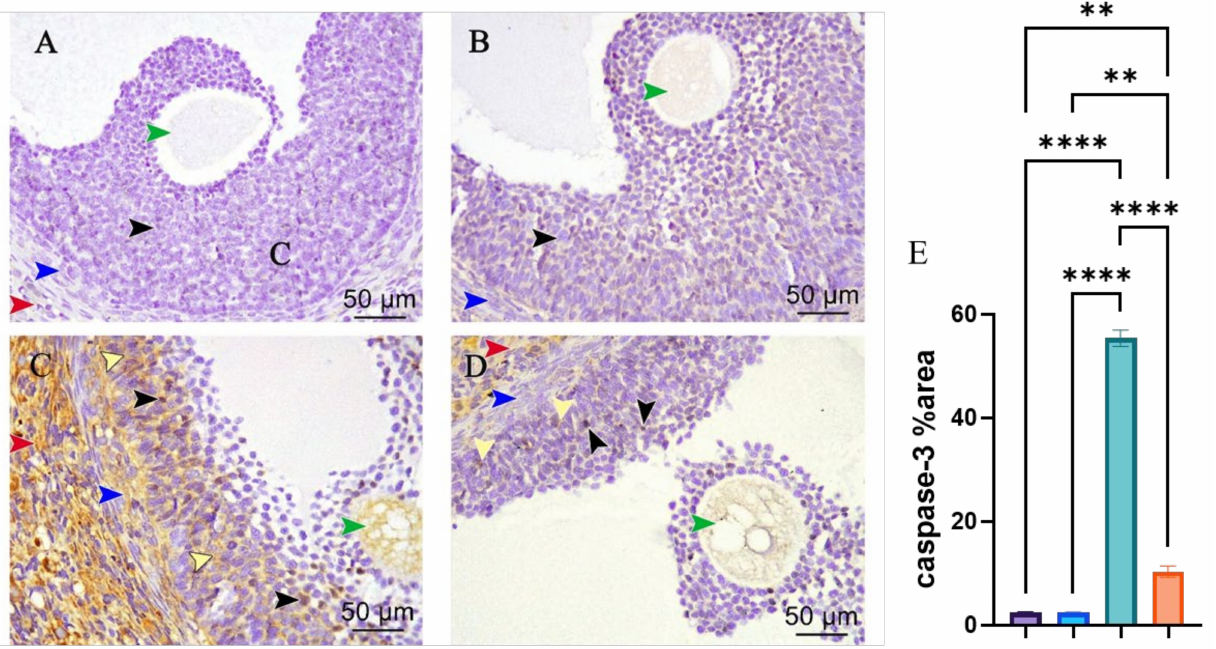
Figure 7. Photomicrographs of Caspase 3 immune reaction (IHC staining × 400) in ovarian sections ( A – E ). ( A ) Control group and ( B ) melatonin group showing Graafian follicle with negative immune reactions in the granulosa (black arrowhead), theca cells (blue arrowhead), stroma (red arrowhead), and the oocyte (green arrowhead). ( C ) Cisplatin-treated group showing degenerating Graafian follicle with a positive immune reaction in the majority of granulosa (nuclear, black arrowheads and cytoplasmic, yellow arrowheads) and in theca cells (blue arrowheads) besides the positive reactions of the oocyte (green arrowhead). Moreover, extensive positive immune reactions in the stroma (red arrowhead). ( D ) Cisplatin + melatonin group showing Graafian follicle with a few granulosa cells with positive immune reactions (nuclear reaction, black arrowhead and cytoplasmic reaction, yellow arrowhead). Few theca cells with positive immune reactions (blue arrowhead) besides the mild positive reactions of the oocyte (green arrowhead) and stroma (red arrowhead) are observed. ( E ) Immunostaining intensity of ovarian caspase-3 (% area). **, and **** indicate significant difference ( p < 0.01, and p <